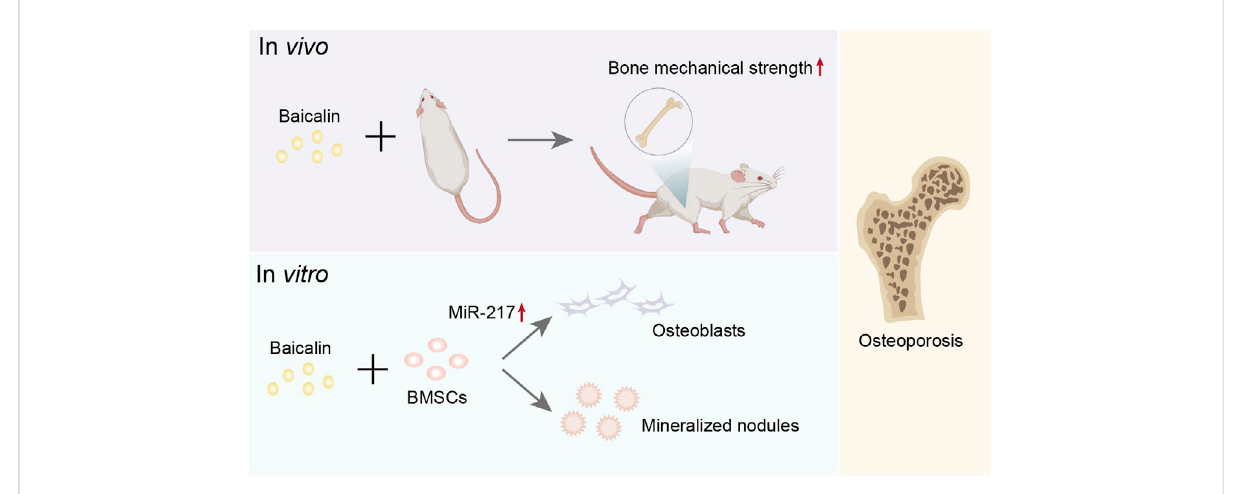
FIGURE 6 Representative schemes illustrating the potential mechanism of Baicalin regulation in the differentiation of